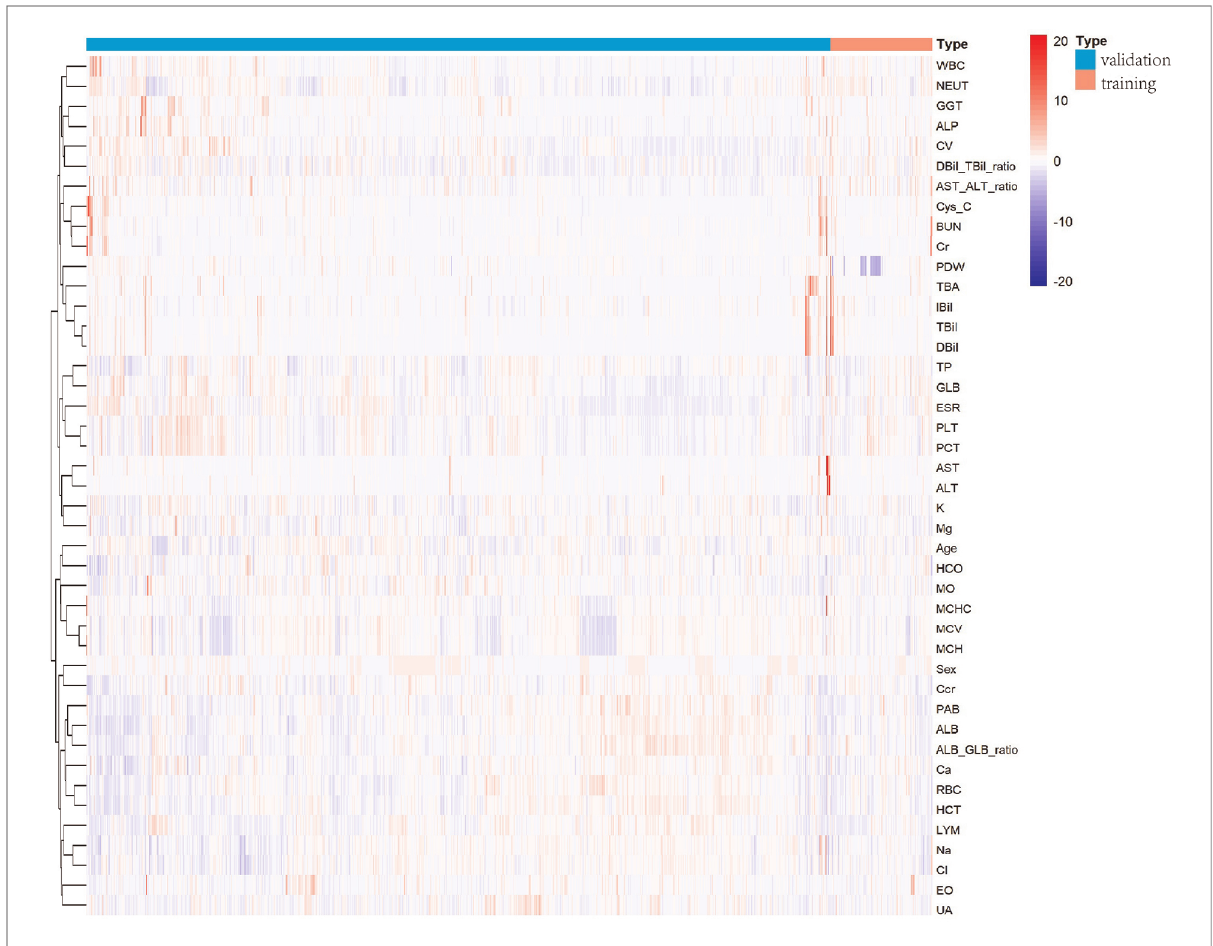
FIGURE 1 Bone and joint TB and TB training cohorts and validation cohorts heat